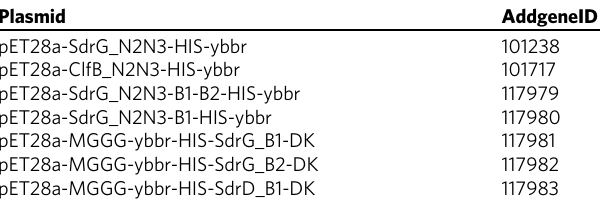
complex dissociates, allowing the cantilever to relax to zero force. f Dynamic force spectrum for the unfolding of the SdrG B1 domain at